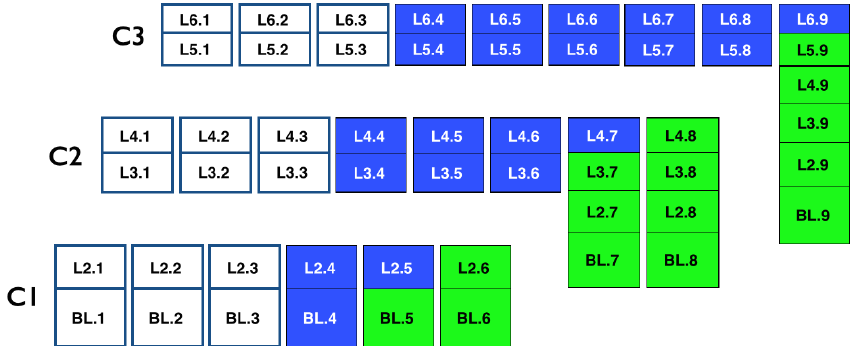
Figure 7. ALD streaming classes using the ICI class composition option—C1 denotes class one, C2 denotes class two and C3 denotes class